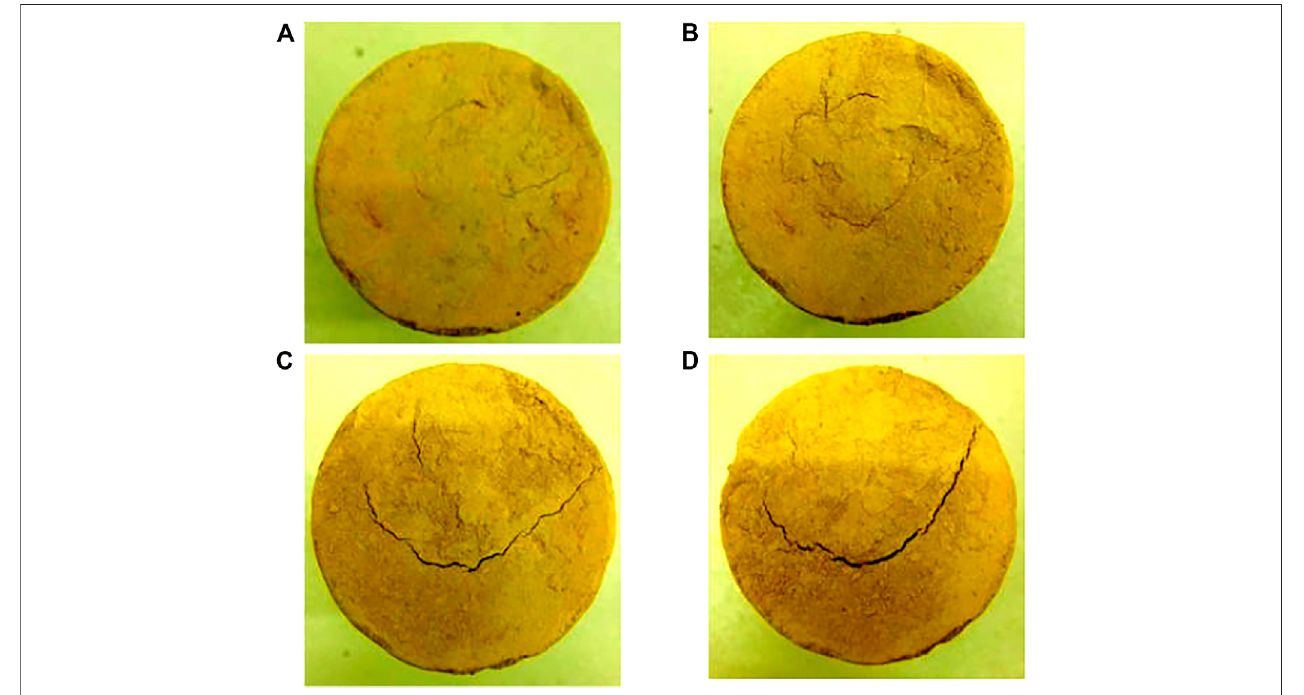
FIGURE 4 | Crack development at the end of each drying process: (A) initial state, (B) after the fi rst drying process, (C) after the second drying process, and (D) after the eighth drying process.